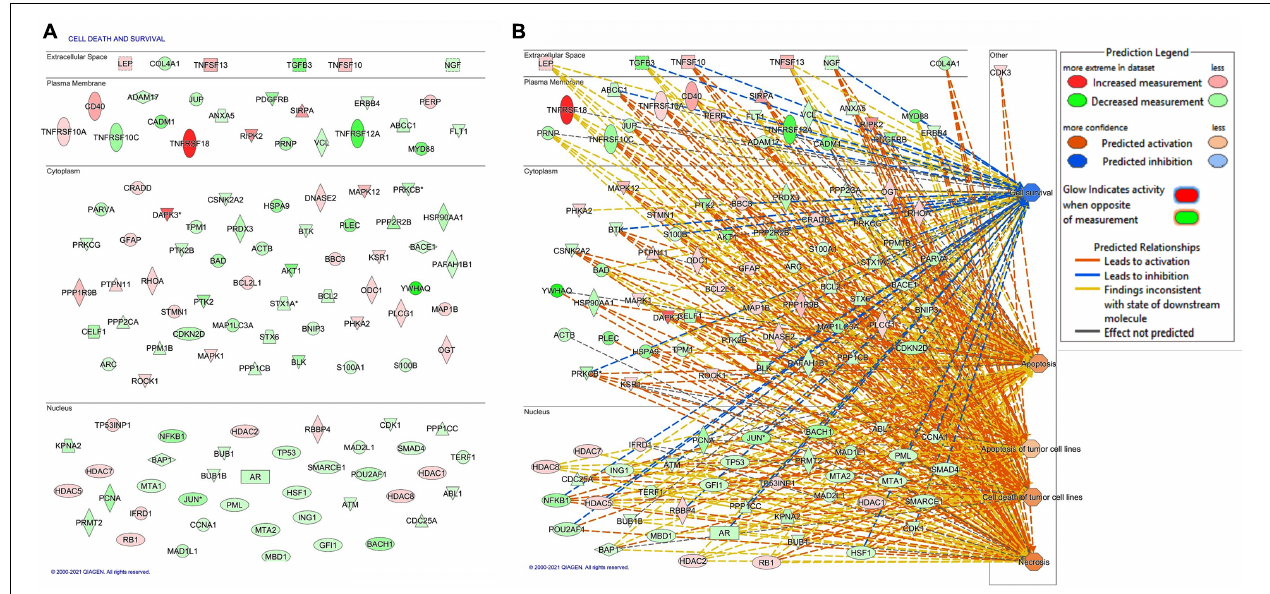
FIGURE 1 | Bioinformatic analysis of differentially expressed protein in FKBP51-silenced melanoma cells. (A) The 117 differentially expressed proteins in FKBP51-silenced melanoma cells associated with cell death and survival. (B) Gene networks generated by IPA pathway analysis from the 117 differentially expressed proteins. Upregulated proteins are shown in red; the downregulated ones are in green. The brightness of color is related to the fold change, and the darker the color, the higher the fold change.